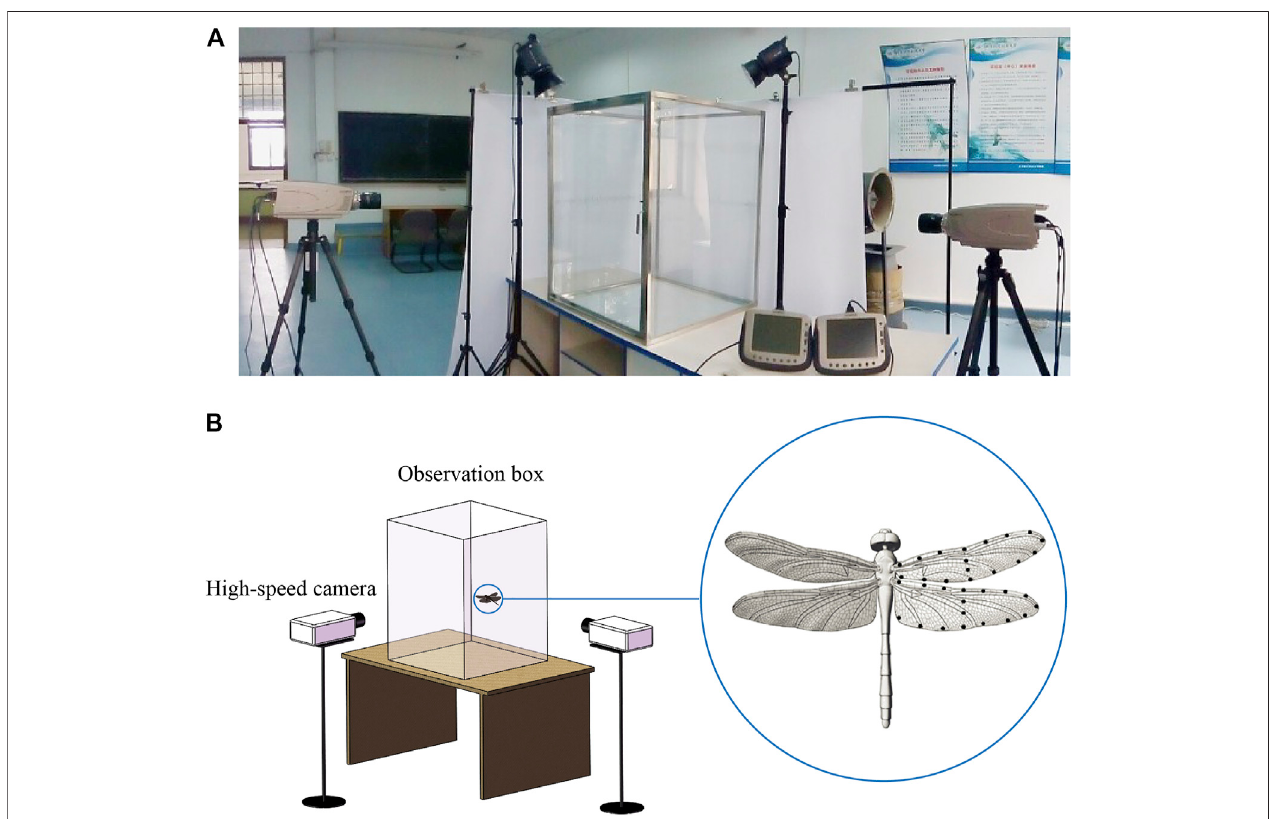
FIGURE 1 | (A) Experimental facilities. (B) Line drawing of experimental facilities and feature points